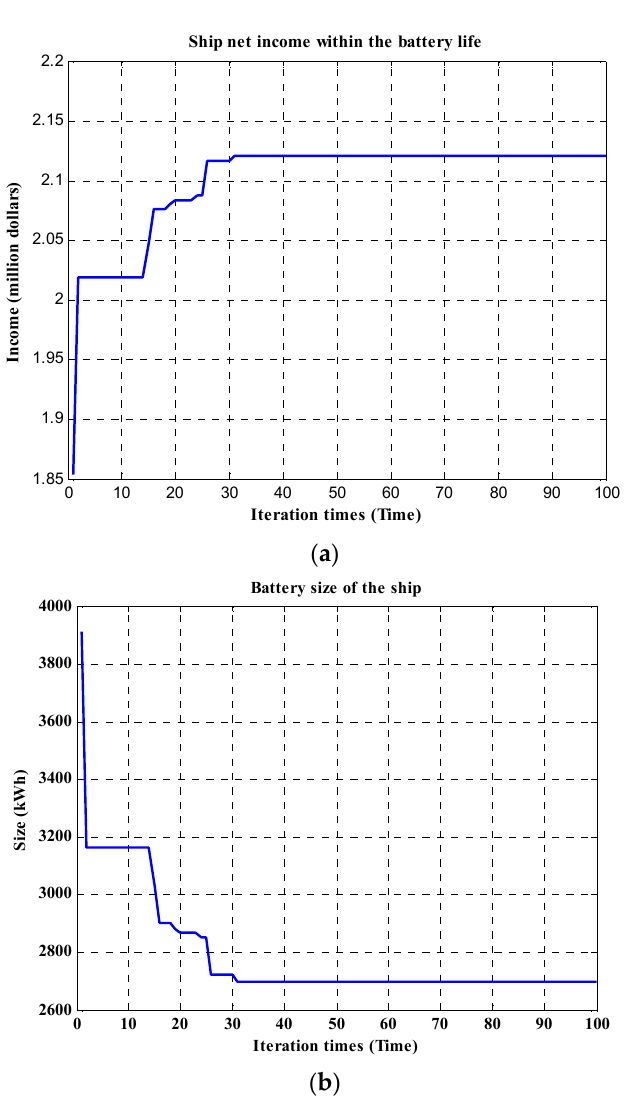
Figure 8. Simulation results of scenario 3 in case 1. ( a ) Variation of ship net income within the battery life over the optimization procedure ( b ) Battery capacity variation over the optimization procedure